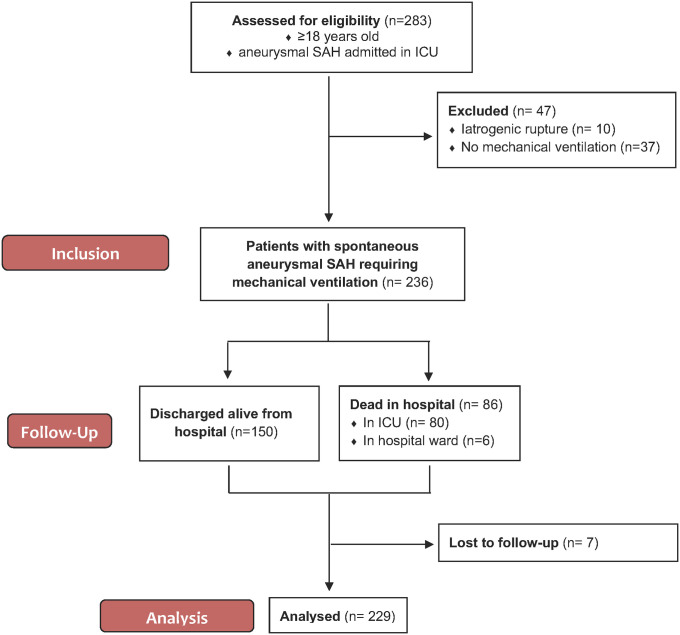
Flow chart of the study design.SAH subarachnoid hemorrhage, ICU Intensive Care Unit.